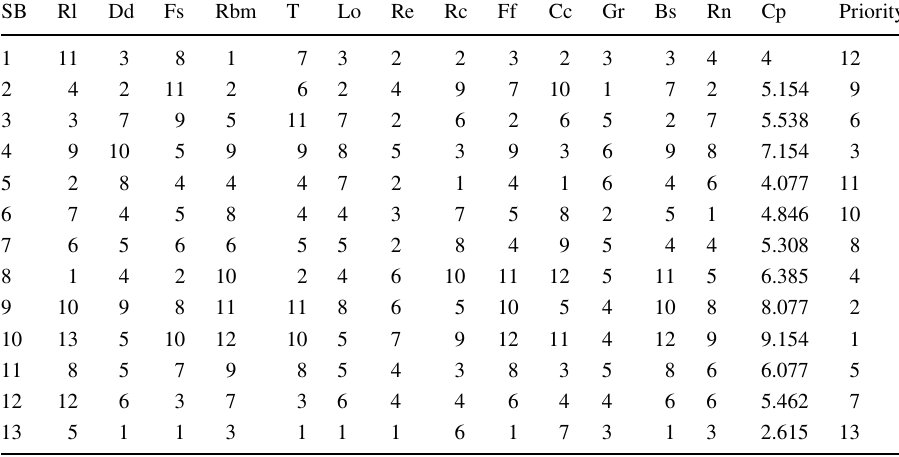
Table 5 Morphometric-based assigned ranking and compound value in Kansai–Kumari inter- fluvial